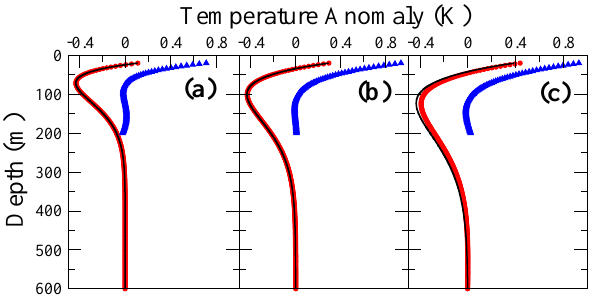
Fig. 3. Temperature anomalies (black lines) generated from the same artificial GSTH as in Fig. 1, but shown here for several val- ues of subsurface thermal diffusivities ( κ ): (a) 0.5, (b) 1.0 and (c) 1.5 × 10 − 6 m 2 s − 1 . Red dots correspond to the anomalies es- timated from boreholes truncated at 600m and blue triangles for those estimated from boreholes truncated at 200m.